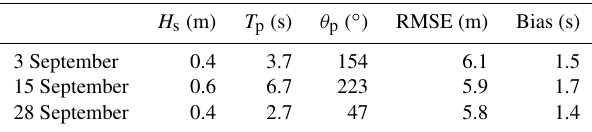
Figure 9. SWAN vs. ADCP scatter plots of H s (a) and T p (b) in Cala Millor.